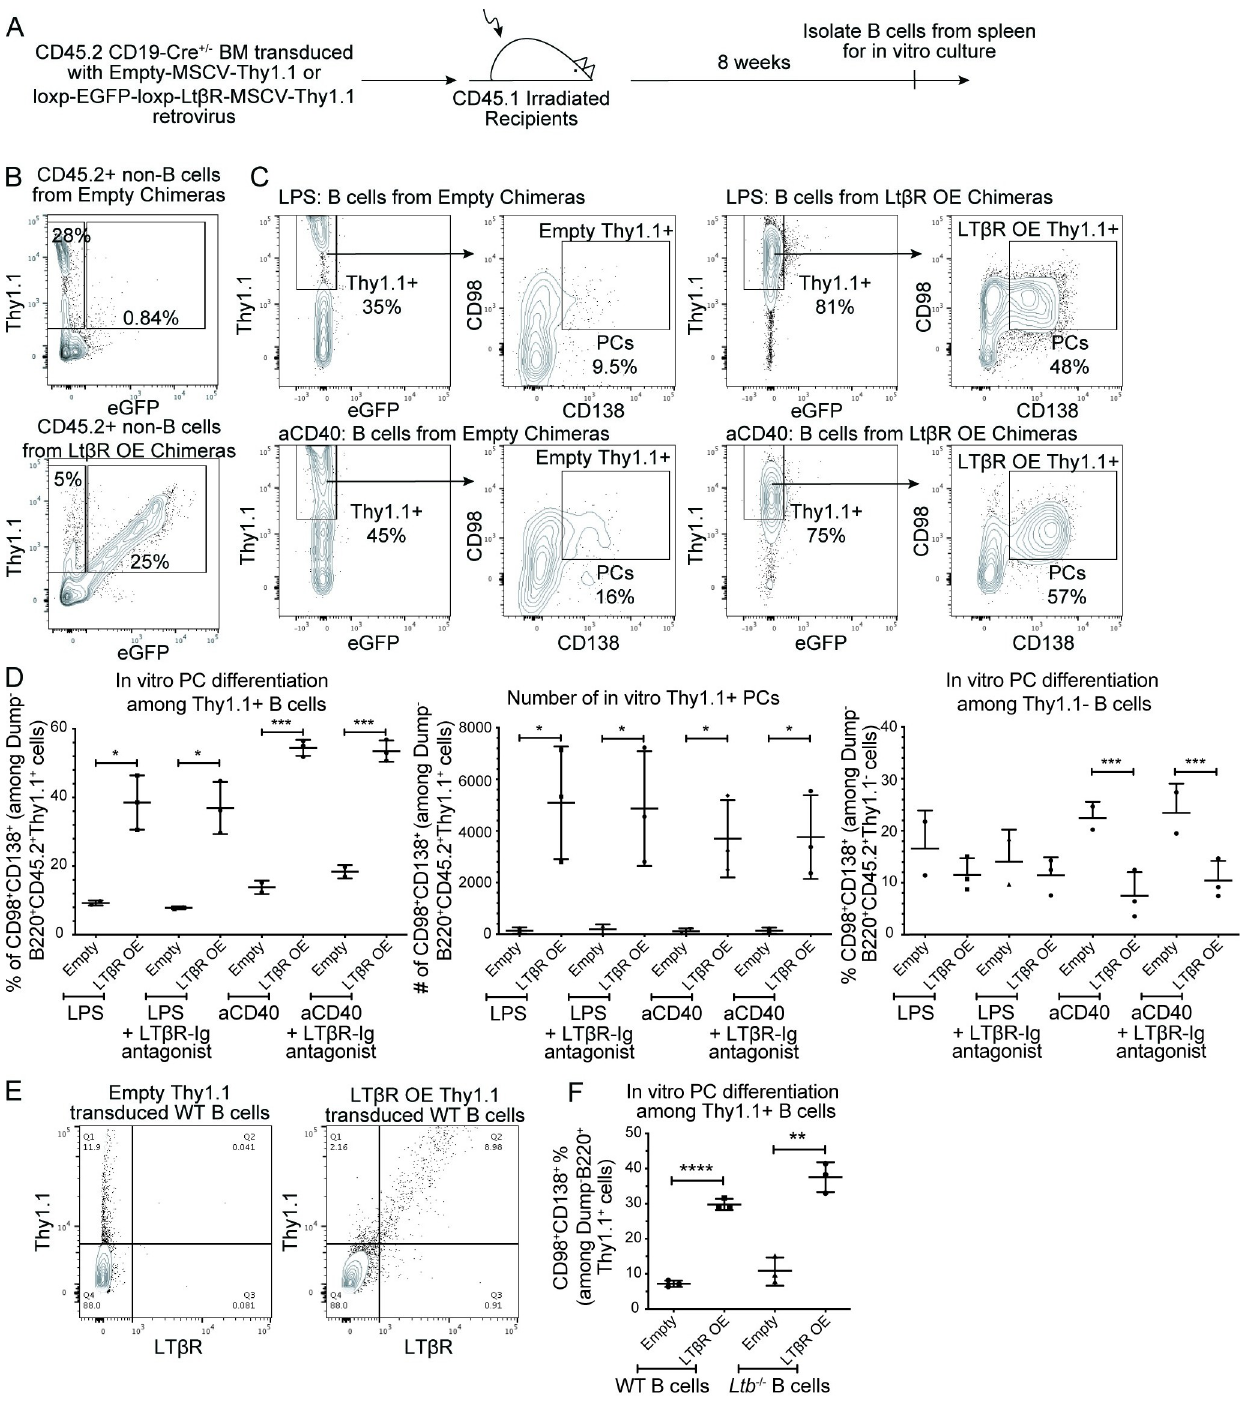
Fig 4. OE of LT β R increases PC numbers in vitro in response to LPS or anti-CD40 stimulation in the absence of ligand. (A) Diagram of experimental scheme. Chimeras were made by retroviral transduction of CD45.2 + CD19-Cre +/- BM with Empty-MSCV-Thy1.1 or loxp-EGFP-loxp-LT β R-MSCV-Thy1.1 retrovirus and transfer into irradiated CD45.1 + recipients. After reconstitution, B cells were isolated from the spleen for in vitro culture. (B) Representative FACS plots of CD45.2 + B220 - splenocytes in chimeras stimulated with or anti-CD40 with IL-4, IL-5, and IL-21 for 3 days. Transduction efficiency based on Thy1.1 expression on FO B cells was 43–93% among the mice analyzed. Blocking of the LT β R ligands was assessed through the addition of human LT β R-Fc blocking antibody. (C) FACS plots of live Dump - B220 + CD45.2 + B cells with gates on Thy1.1 + cells and further gates on CD98 + CD138 + PCs. (D) Percentages of CD98 + CD138 + PCs among Thy1.1 + (left) and Thy1.1 - (right) B cells as gated in B. Numbers of CD98 + CD138 + Thy1.1 + PCs (middle). (E)